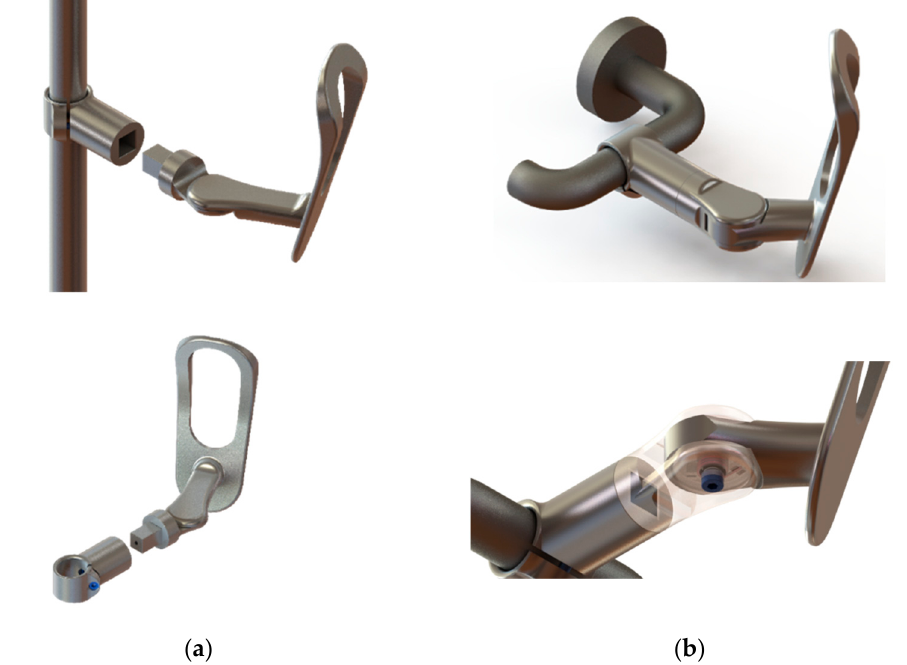
Figure 5. Three-dimensional visualization: ( a ) ADOD-V4 system with a simple clamp and spring; ( b ) ADOD-V5 system with a double clamp and a double spring.